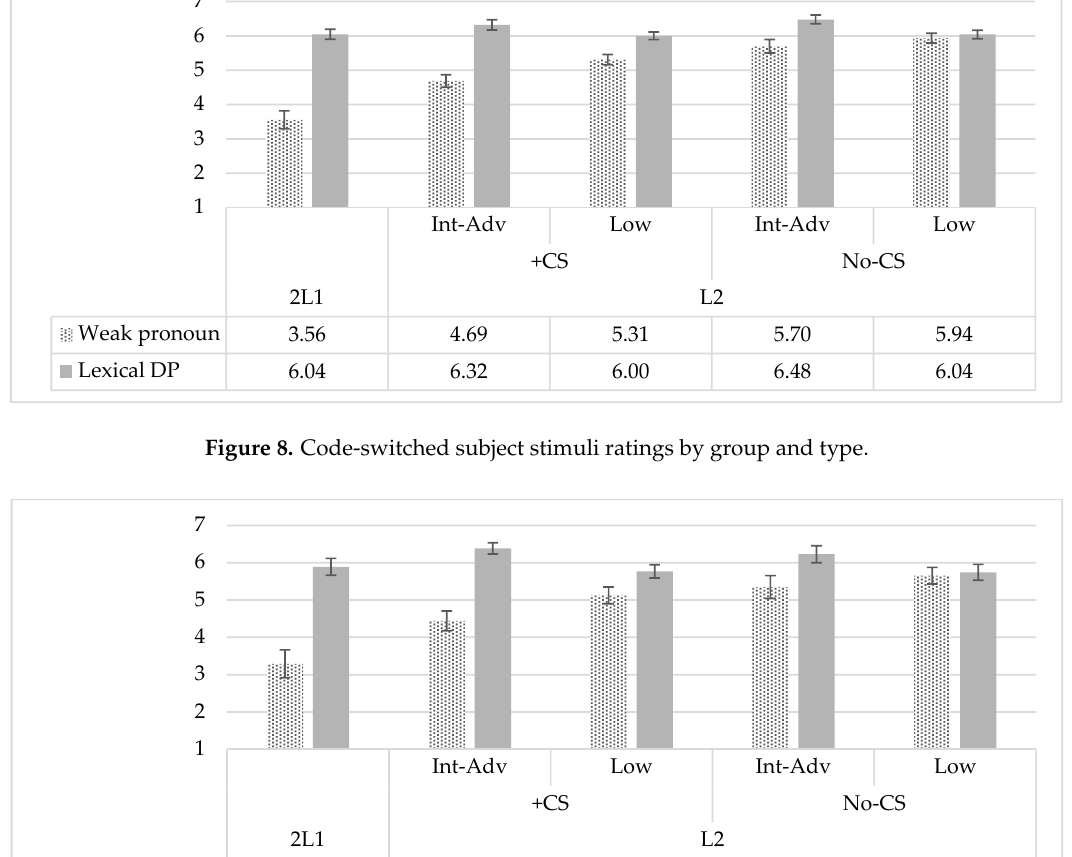
Figure 7. Monolingual Spanish subject stimuli ratings by group and type.